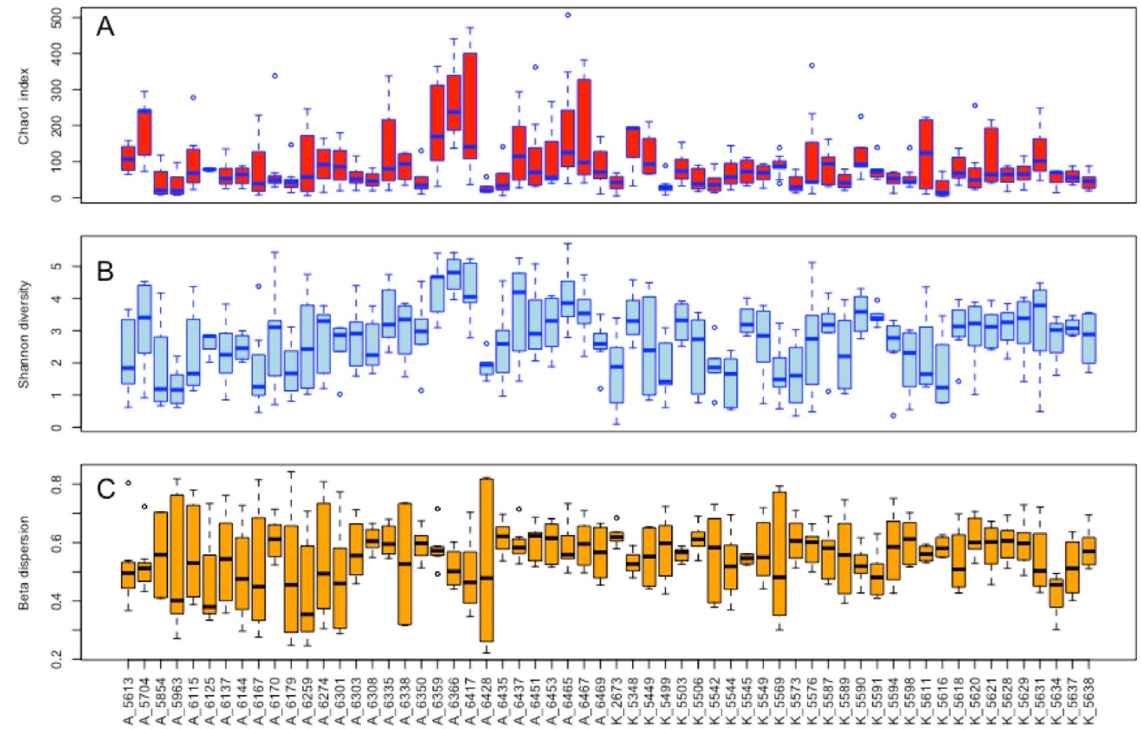
Figure 4. Boxplot of the alpha diversity indexes ( A : chao1 estimate, B : Shannon diversity) grouped per individual cows. ( C ) Multivariate homogeneity of group dispersions obtained using the Bray–Curtis dissimilarity matrix and grouped per